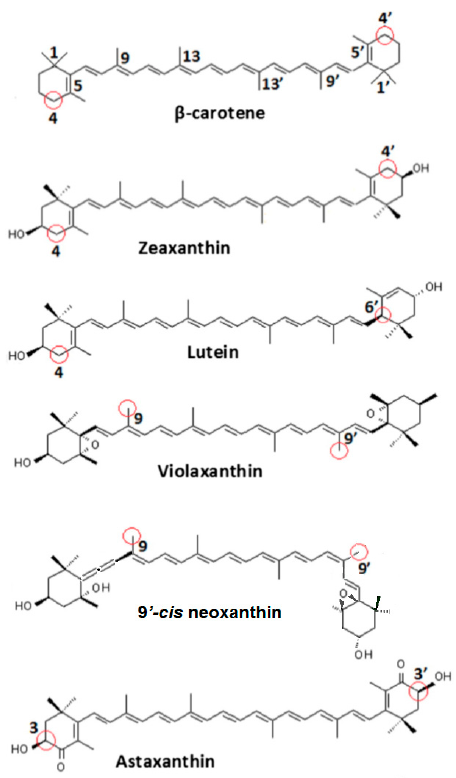
Figure 4. Carotenoid structures. Circled in red are the most favorable positions for proton loss from a radical cation.